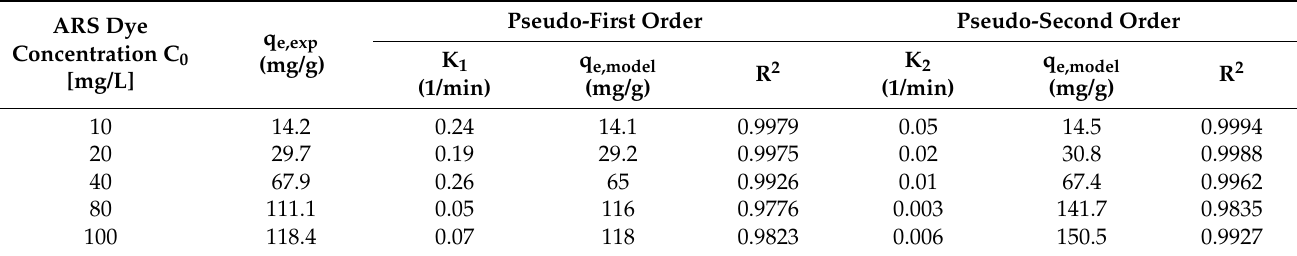
Table 3. Lagergren pseudo-first order and pseudo-second order kinetic parameters for the ARS dye adsorption onto the MCN. ARS Dye Concentration C